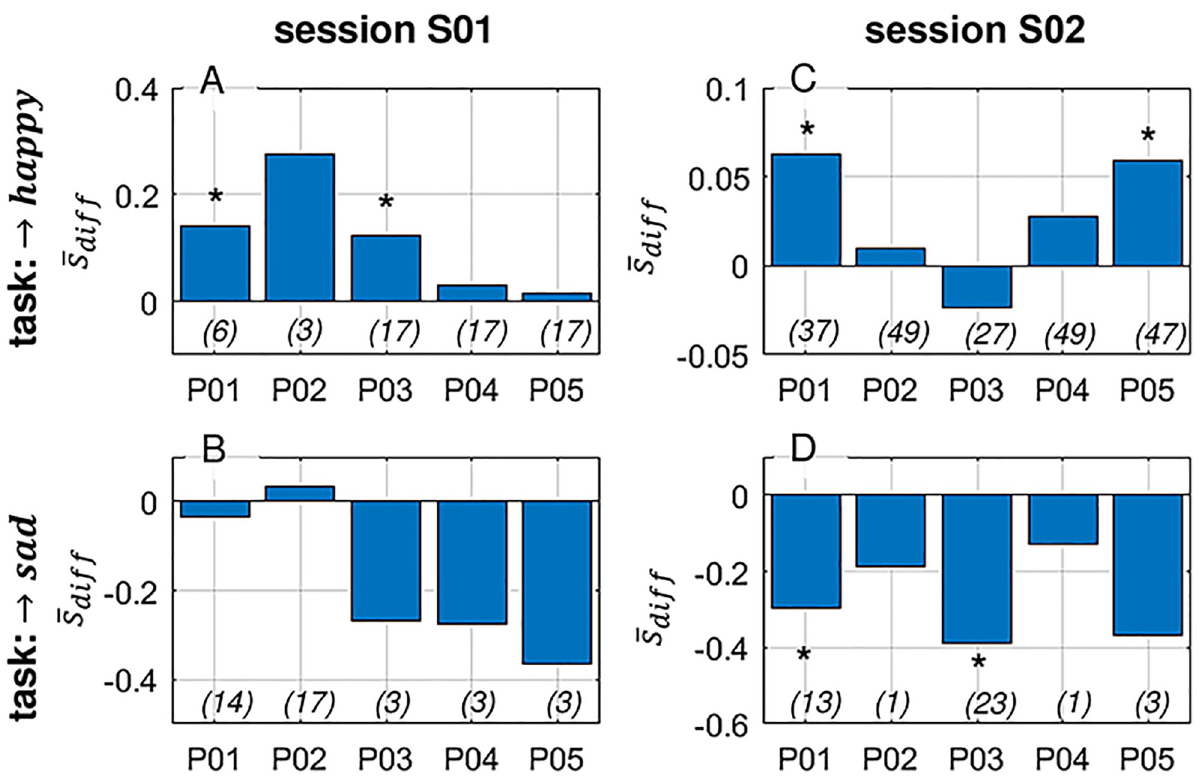
Fig 6. Average modulation performance. The bars represent the mean difference � s corresponding resting period, averaged across trials (Eq 11) separated in sessions (S01: A and B; S02: C and D) and task ( ! happy : A and C; ! sad : B and D). Numbers in parentheses denote the number of trials for the respective participant/task/session combination and the asterisks ( � ) those combinations with significant modulation